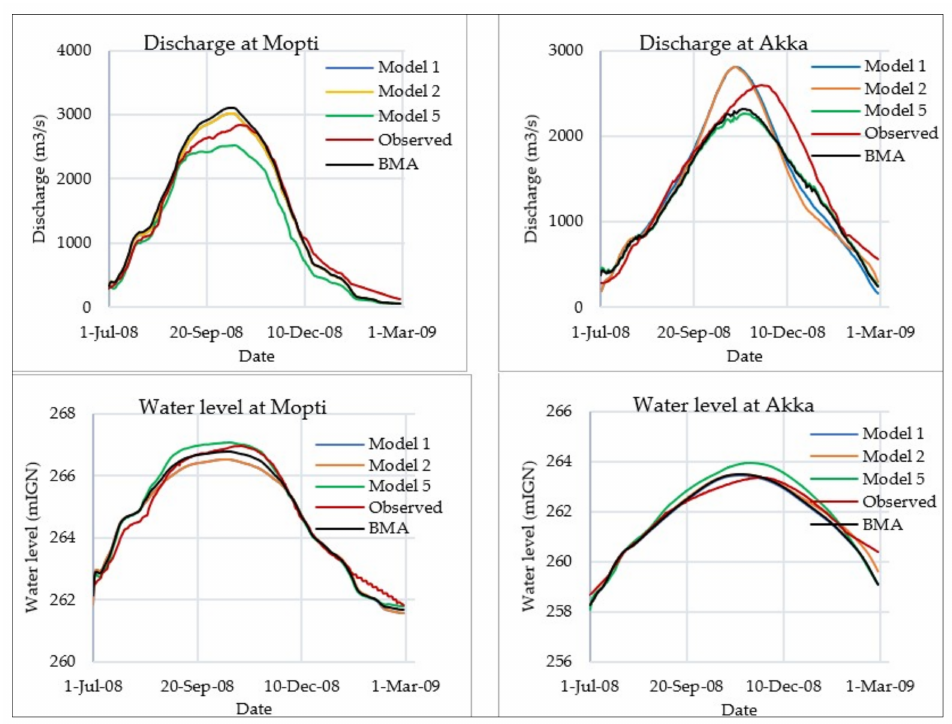
Figure 11. Comparison of discharge ( top ) and water level ( bottom ) from the best individual models and BMA prediction at the